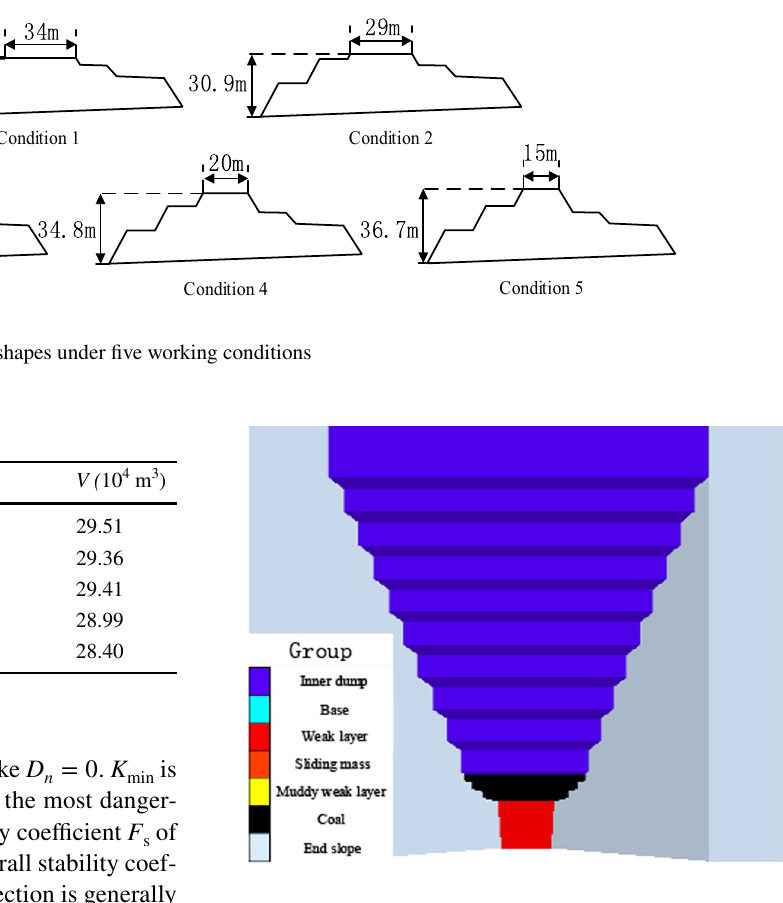
Fig. 13 Numerical simulation